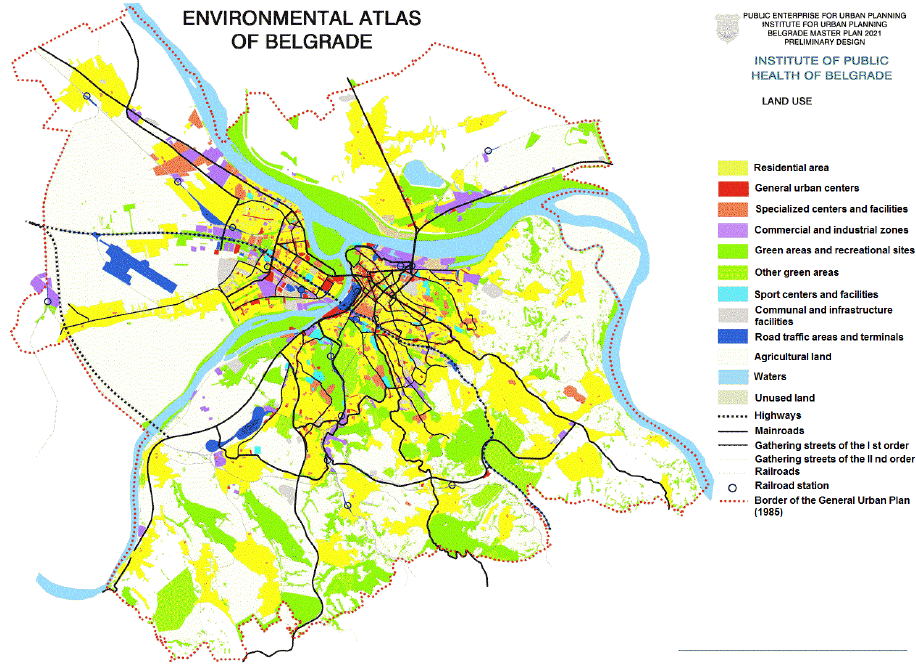
Figure 2. Land use (https://www.zdravlje.org.rs/ekoatlas/volbe/03ev.gif, accessed on 23 August 2022).